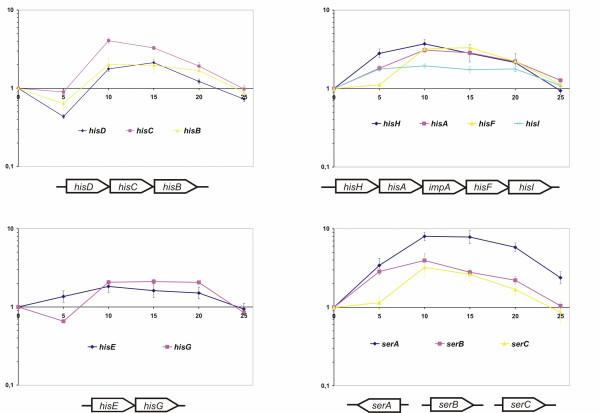
Time course analysis of expression of the histidine and serine biosynthesis genes after treatment with DL-serine hydroxamate. The samples were taken in five minute intervals up to a total of 25 minutes. The relative amount of mRNA was measured by real-time RT-PCR with a LightCycler instrument. The expression ratios were determined by calculating the ratio of t0 (untreated) and t5–25 (treated) samples from four experiments. Below the diagrams, the organization of the respective genes in the C. glutamicum chromosome is depicted.